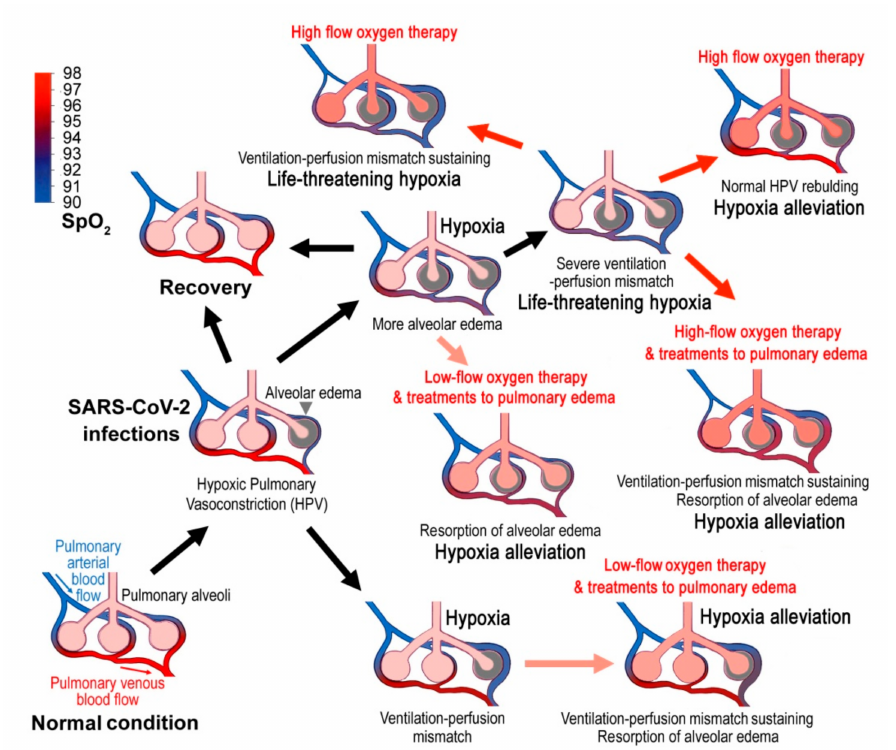
Figure 1. Hypothetically pathogenic mechanisms of COVID-19 and the corresponding therapies. Virus infections cause alveolar edema and the hypoxic pulmonary vasoconstriction (HPV), which is an essential protection mechanism of the lung that directs blood perfusion from badly-ventilated to well- ventilated alveoli to optimize gas exchange. However, SARS-CoV-2 infections may cause mismatched blood flow and alveolar ventilation, and may result in life-threatening hypoxemia. Treatments to pulmonary edema might promote lung edema resorption and show good therapeutic effects. When the disease develops into late stages, systemic alveolar edema and severe ventilation-perfusion mismatch occurs, and the blood oxygen will decline sharply. Then the high-flow oxygen therapy will be required. However, high-flow oxygen inhalation may not correct ventilation-perfusion mismatch and cause several adverse effects. The blue to red gradient bar shows blood oxygen saturation (SpO 2